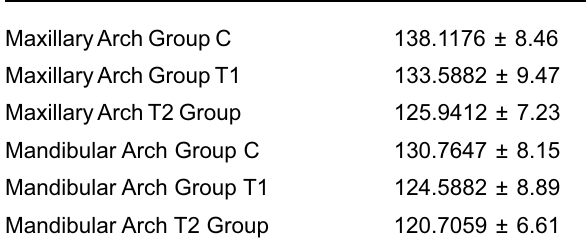
TABLE 4- Maxillary and mandibular dental arch perimeters